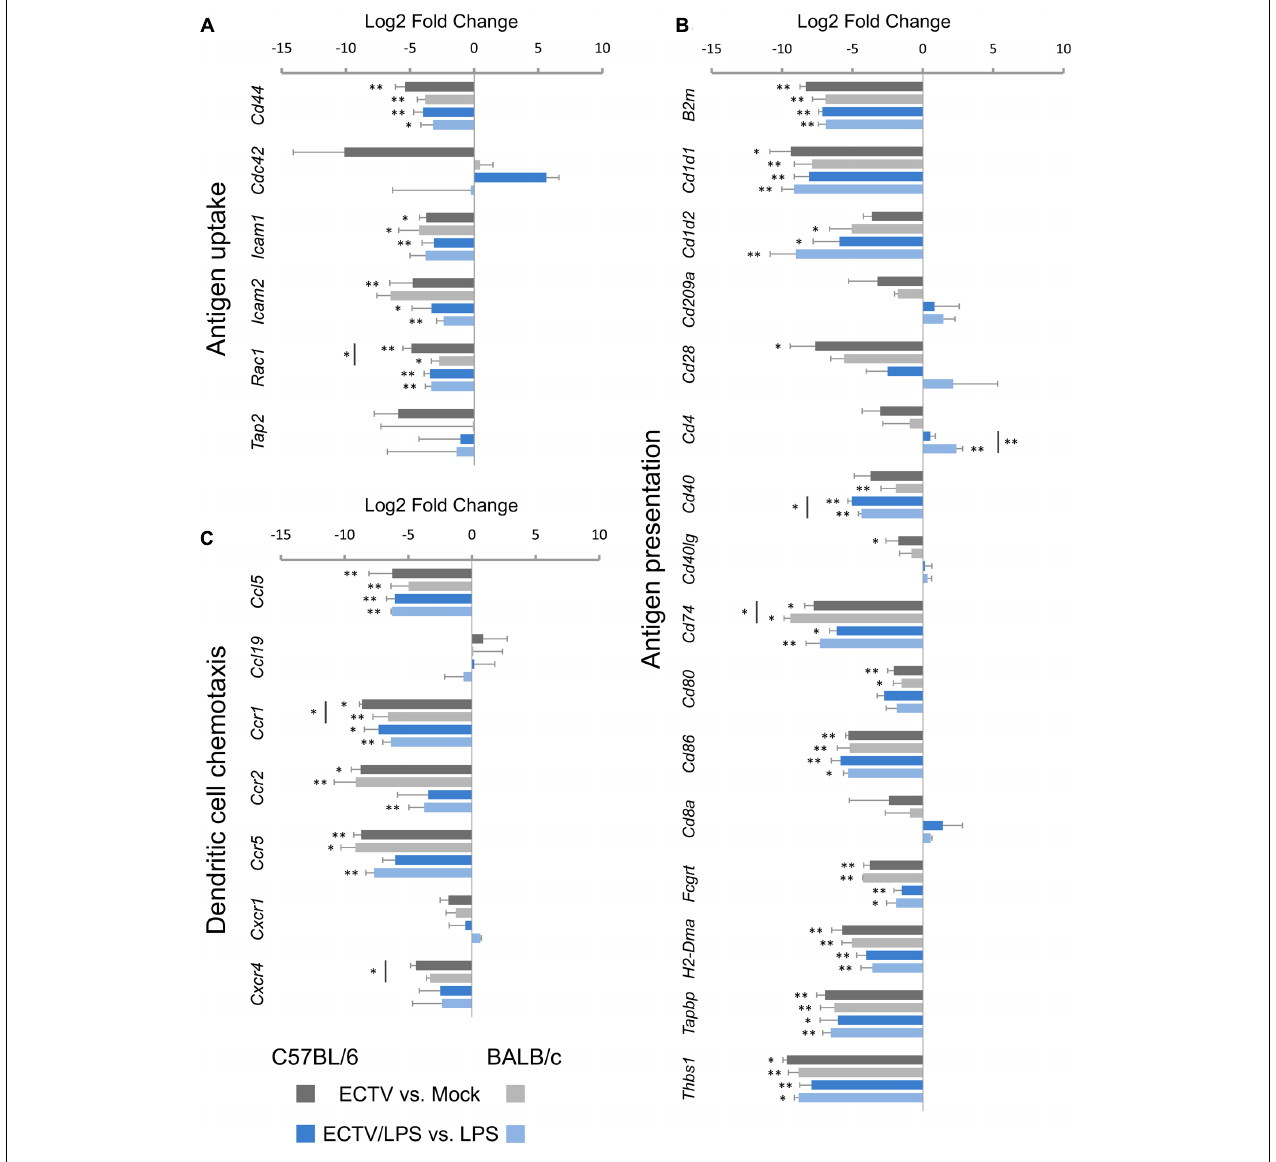
FIGURE 4 | Mouse strain-independent effect of ECTV infection on the expression of genes involved in (A) antigen uptake, (B) antigen presentation, and (C) chemotaxis in GM-BM (unpaired Student’s t -test; ∗ P < 0.05, ∗∗ P < 0.01).